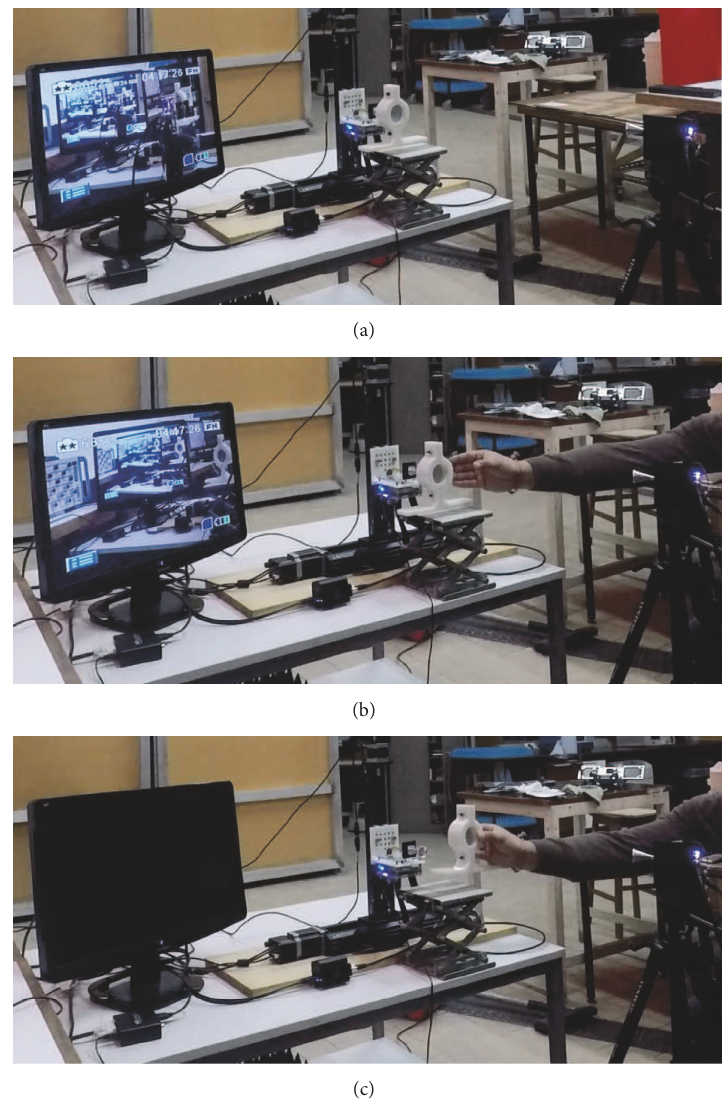
Figure 6: Photographs of the video transmission experiment: successful transmission with the lens at (a) 0 ∘ and (b) 36 ∘ ; (c) unsuccessful transmission without the lens at 36 ∘